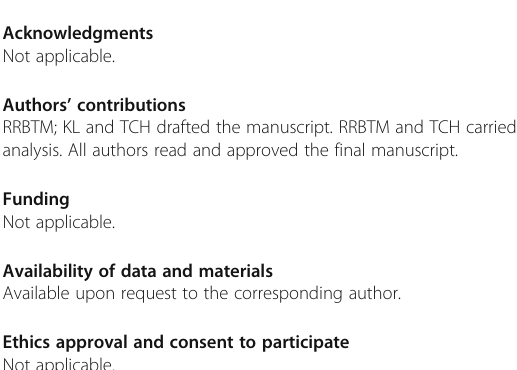
Additional file 1: Figure S1. Forest plot showing the results of the meta-analysis (One study was excluded) (TIF 10038 kb) Acknowledgments Not